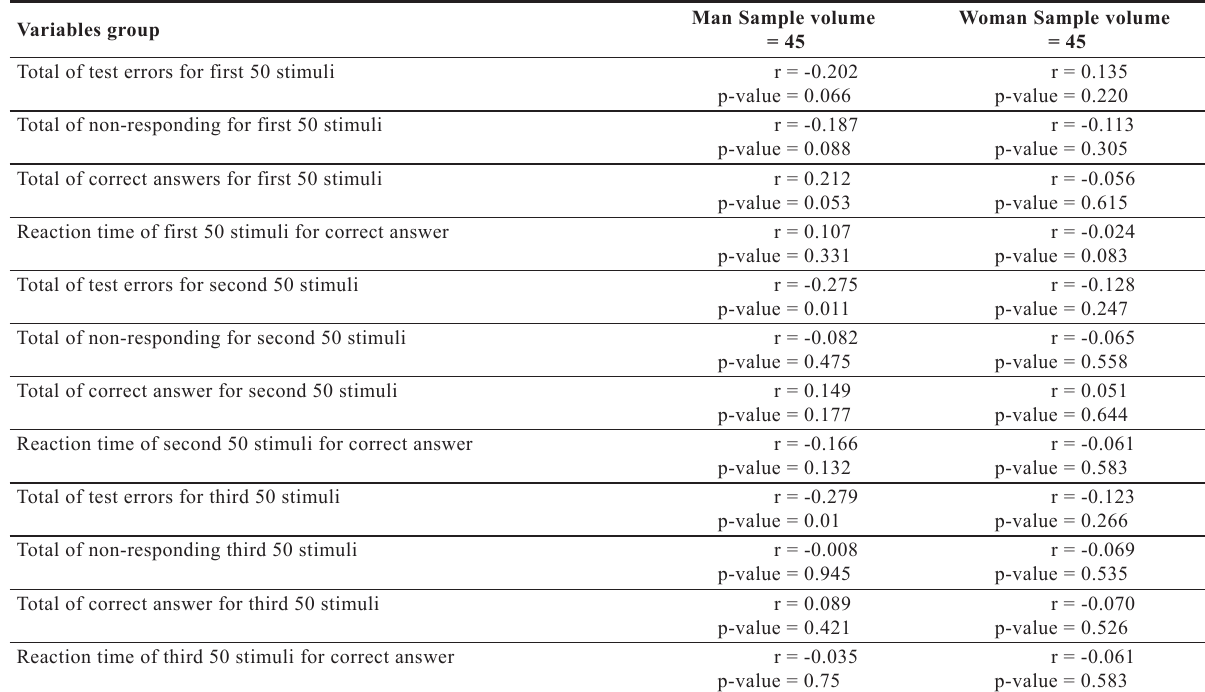
Table 5. the relationship and correlation values between genders by variables of SAIT